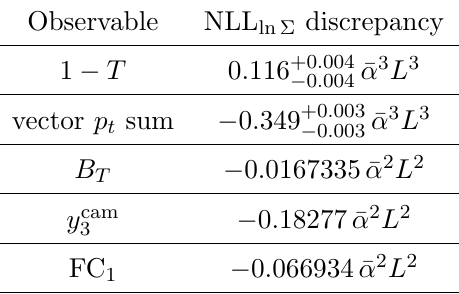
Table 1. The table summarises the NLL di(cid:11)erence between the Pythia and Dire shower-algorithm results and the analytic resummation for di(cid:11)erent observables, at the (cid:12)rst non-trivial perturbative order in (cid:22) (cid:11)L = 2 C F (cid:11) s L=(cid:25) . The quoted uncertainty in the results, whenever present, corresponds to the statistical integration